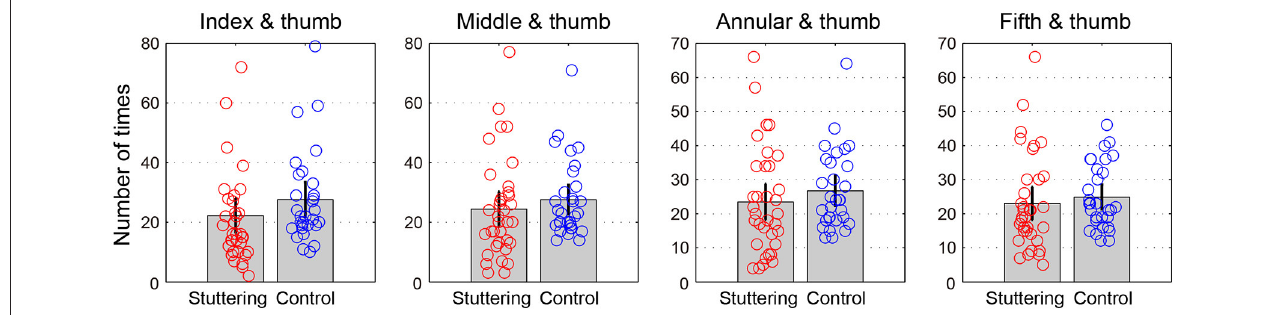
FIGURE 3 | Rotation task 2. The y-axis represents the number of times performed in 15s for each finger pair. Error bars represent 95% confidence intervals.